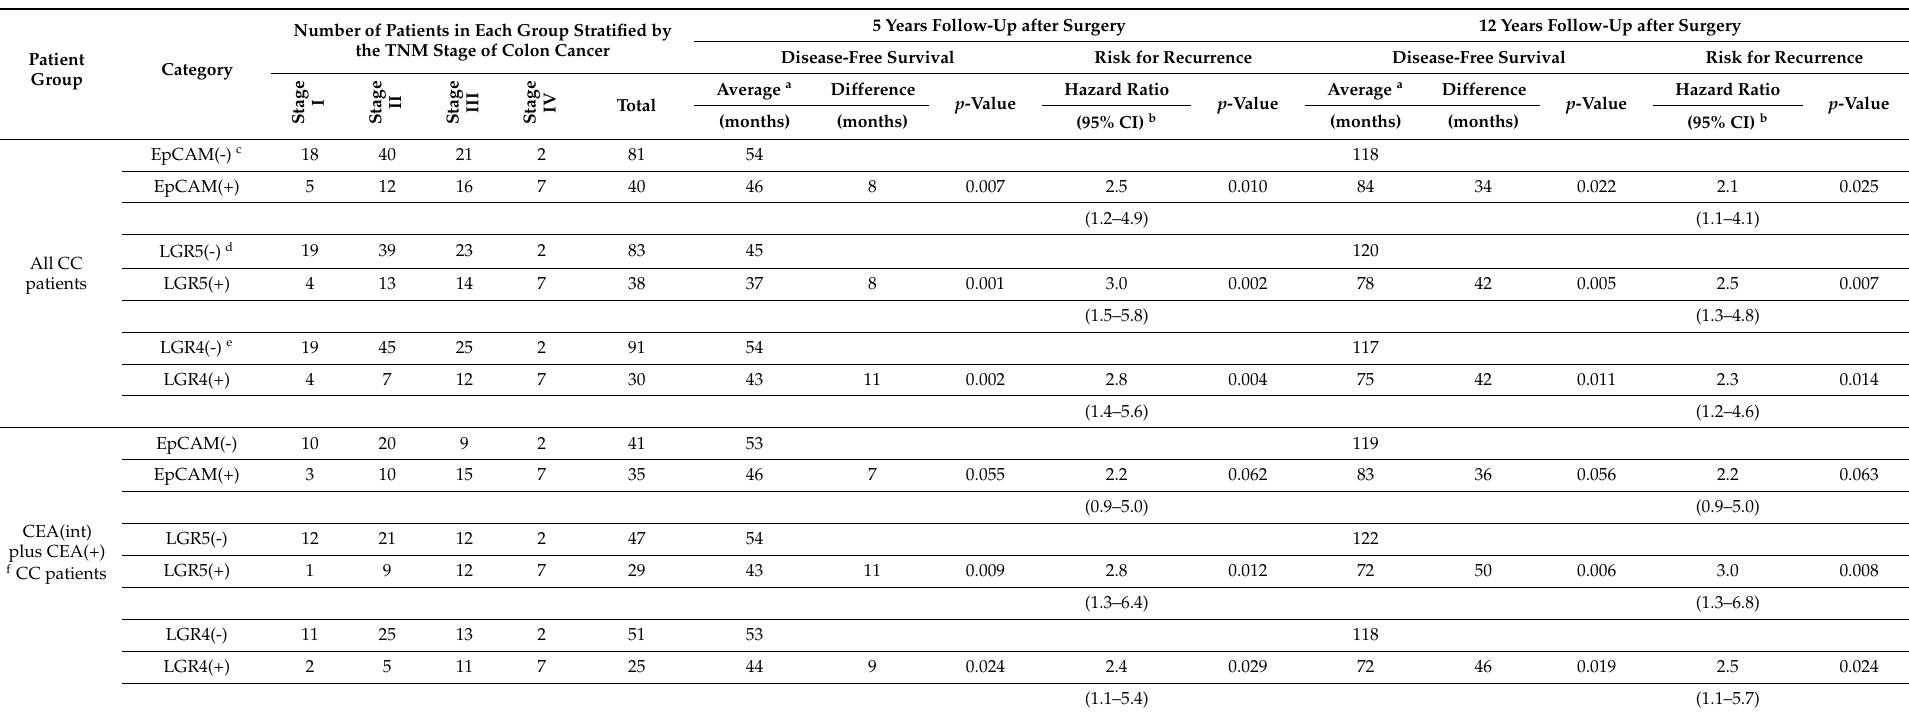
Table 2. Comparative analysis of average survival time after surgery and risk for recurrence of disease of CC patients with EPCAM(-) and EpCAM(+), LGR5(-) and LGR5(+) and LGR4(-) and LGR4(+) lymph